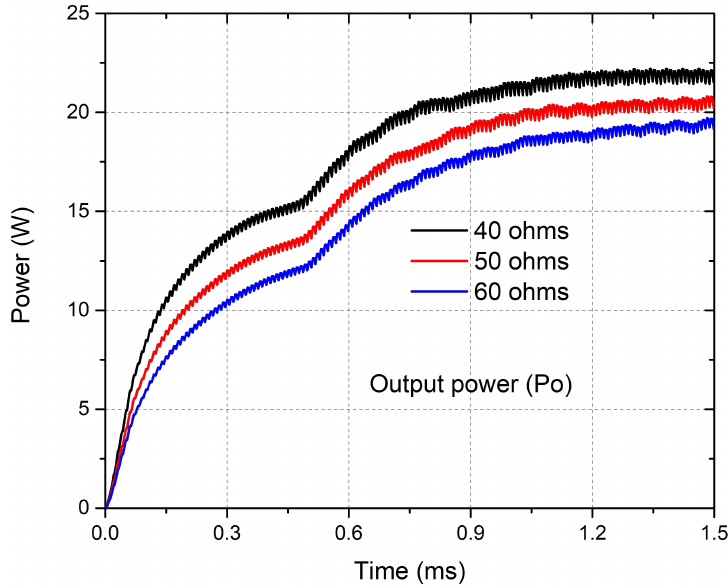
Figure 17. Output power plot obtained using P&O algorithm.